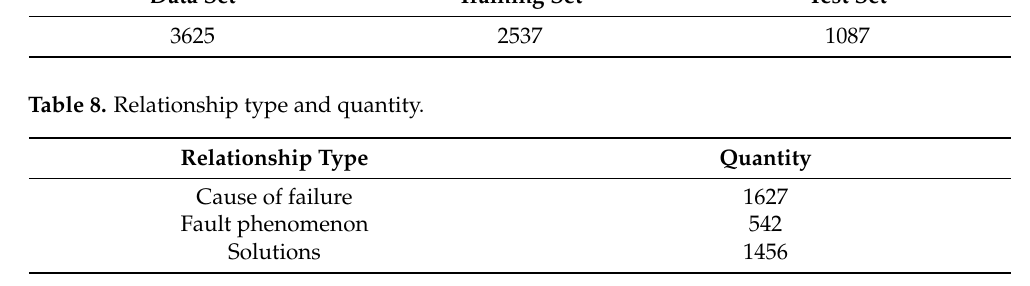
Table 7. Specific size of data set for relation extraction. Data Set